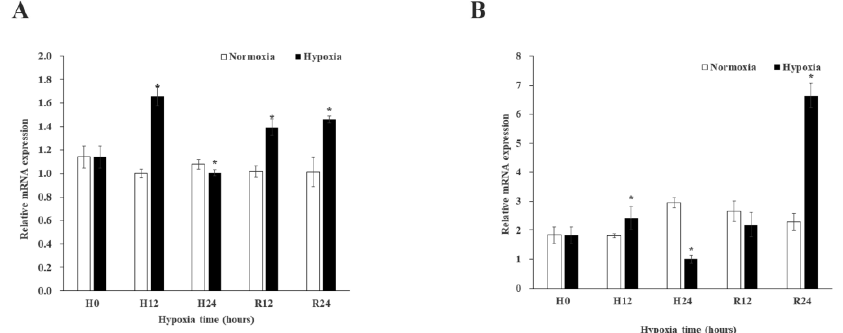
Figure 4. Expression of MnGST-1 ( A ) and MnGST-2 ( B ) in the gill of M. nipponense at five time points after hypoxia and reoxygenation (H0: hypoxia for 0 h; H12: hypoxia for 12 h; H24: hypoxia for 24 h; R12: reoxygenation for 12 h; R24: reoxygenation for 24 h). Data indicated with asterisks are significantly different ( p < 0.05) between treatment and control groups. Values are means ± SE for triplicate samples.